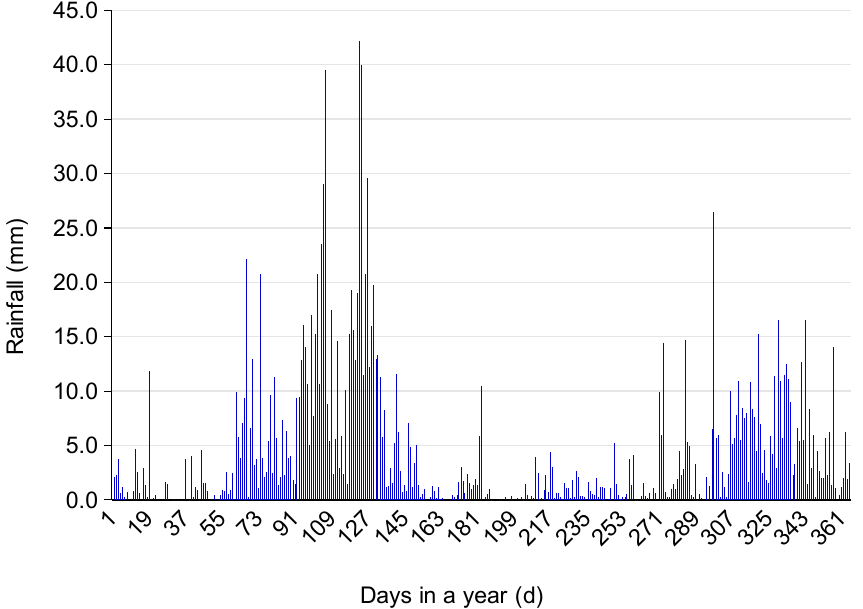
Figure 2. Average daily rainfall data for Zanzibar for the period 2011–2018 (Source: Tanzania Meteorological Agency, Zanzibar office).